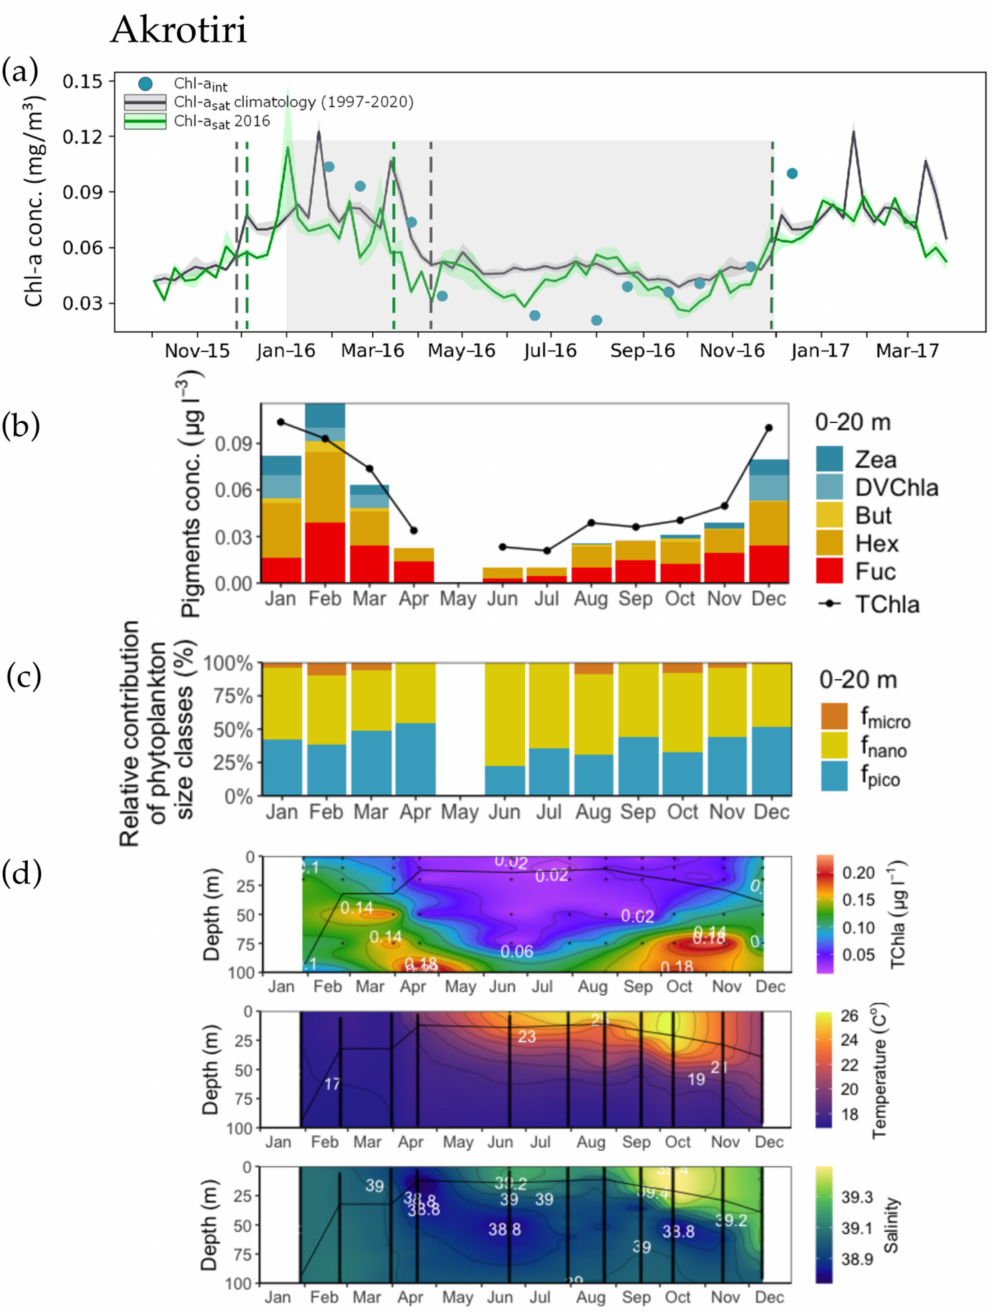
Figure 3. Time series of satellite-derived Chl-a consecrations, diagnostic pigment concentrations and vertical profiles of total Chl-a, temperature, and salinity in Akrotiri (AKR) station. ( a ) Climatology time-series (based on 23-year OC-CNR data of daily composites) (Chl-a sat climatology (1997–2020) in comparison with satellite-derived Chl-a concentration from October 2015 to March 2017 (Chl-a sat 2016). Blue dots represent the in situ measurements (Chl-a int ) taken between January and December 2016 (shaded area). The dashed lines represent the timing of initiation and termination of the main phytoplankton growth, ( b ) Diagnostic pigments concentrations for the 0–20 m layer, ( c ) Percentages associated with the pico- (fpico), nano- (fnano) and micro-phytoplankton (fmicro) size classes, for the 0–20 m layer, ( d ) Vertical profiles of CTD temperature, salinity, and HPLC total Chl-a concentration. The black line represents the Mixed-Layer Depth (MLD). Note: The in situ data are a snapshot (one day in each month) compared to the weekly averages of the satellite retrieved